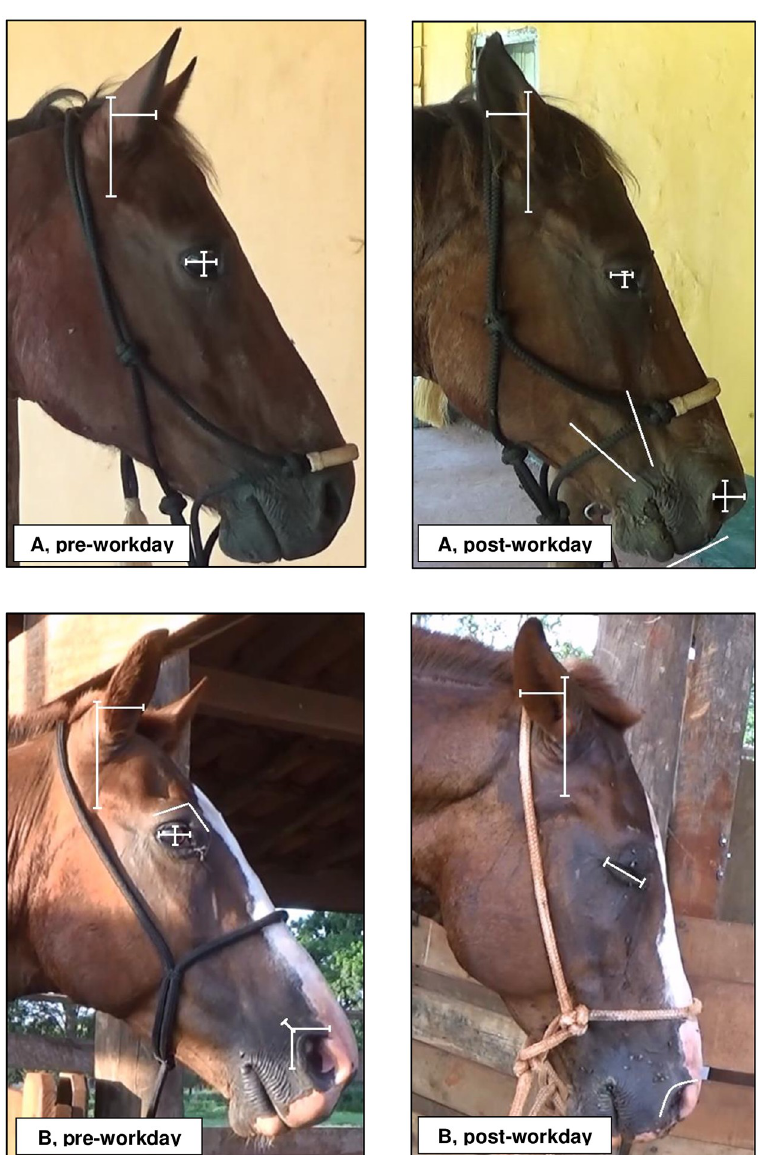
Fig 1. Still images from 30-s video clips of two ranch horses (A and B) pre- and post-workday. The images show both ranch horses orienting their ears forward and backward before and after workday, respectively. Horse A has its eye partially closed (A, post-workday), while horse B has its eye fully closed and is showing contraction of the eyelid post-workday. Horse A showed contraction of the inner brow raiser before and after the workday, and showed tension of the muzzle and mimic muscles post-workday. Horse B showed nostril lift before workday. See Table 2 for descriptions of the categories of facial